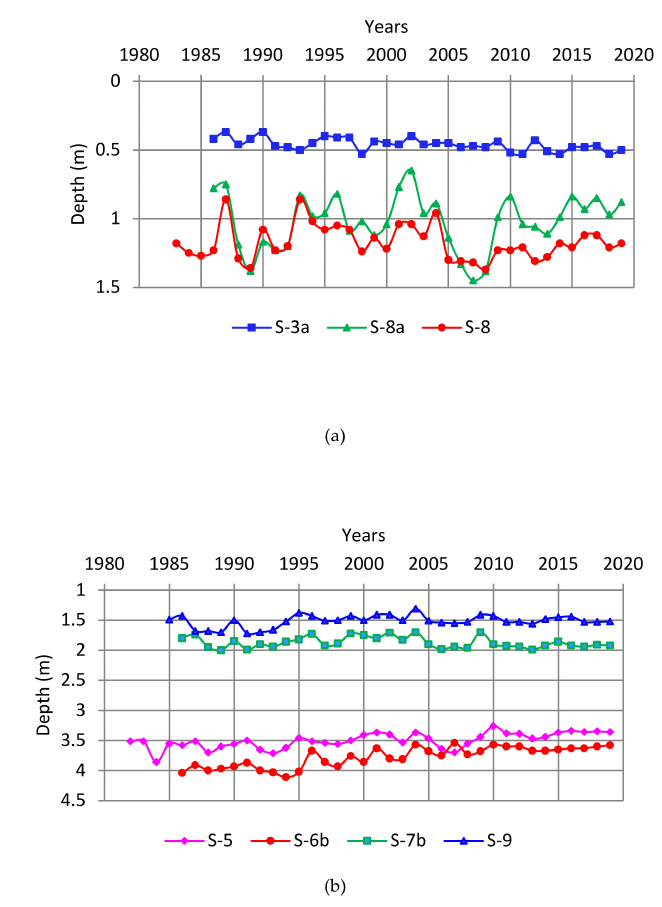
Figure 8. Long-term variability of the active-layer thickness in the shallow ( a ) and slope ( b ) types of localities at the Chabyda